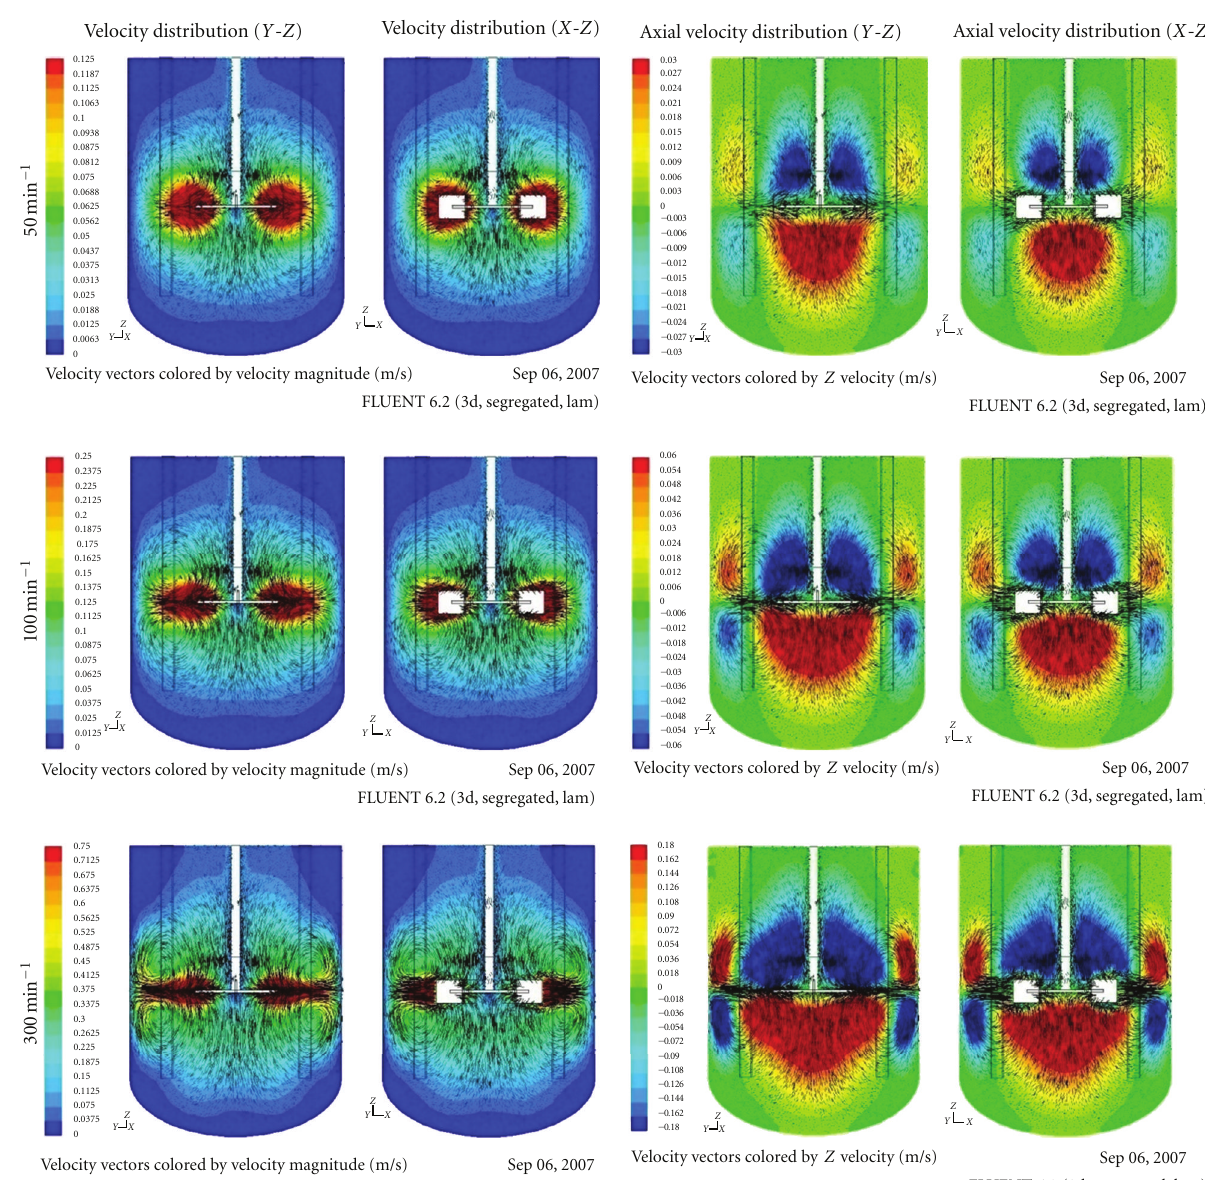
Figure 5: Three-dimensional flow velocity and axial velocity distribution (vertical located impeller). The rate vector was overlapped with each figure. The range of coloring was displayed in proportion to the rotational